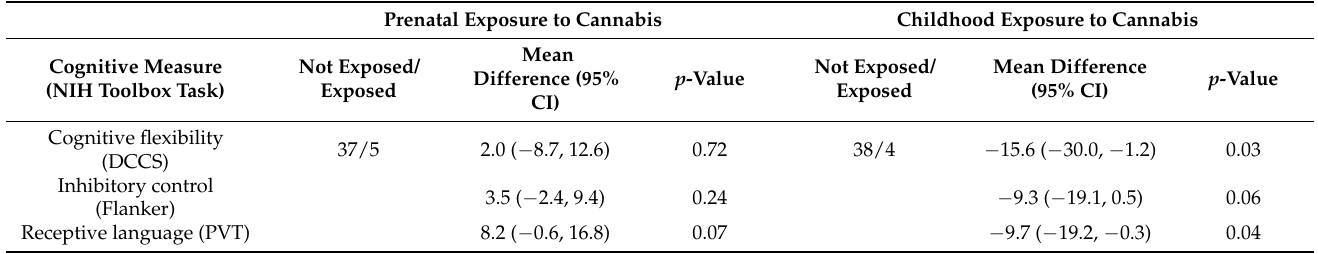
Table 5. Associations between prenatal and childhood exposure to cannabis with childhood cognition, n =